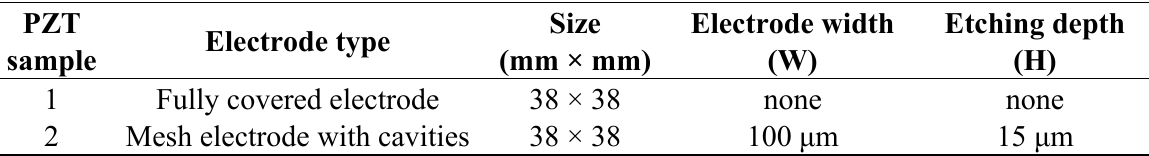
Table 3. Samples for the PZT pyroelectric cells.